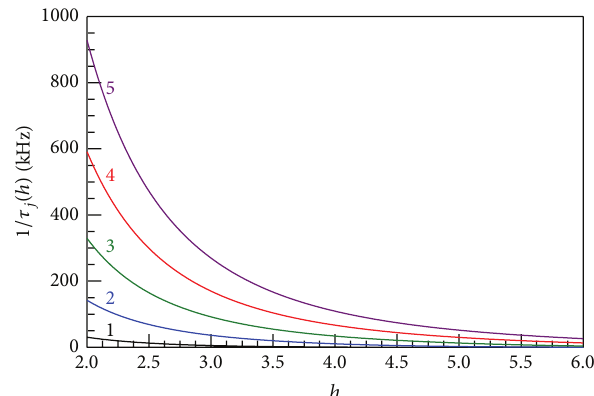
Figure 3: The inverse depletion times 1/𝜏 𝑗 for the lowest gravita- tional states 𝑗 = 1; 2; 3;4; 5 for a waveguide with 1D exponential roughness with 𝜂 = 𝑟 = 1 . The curves are marked by the values of 𝑗 . The vertical scale is in kHz. Equation (33) extends the results to other values of 𝜂 and 𝑟